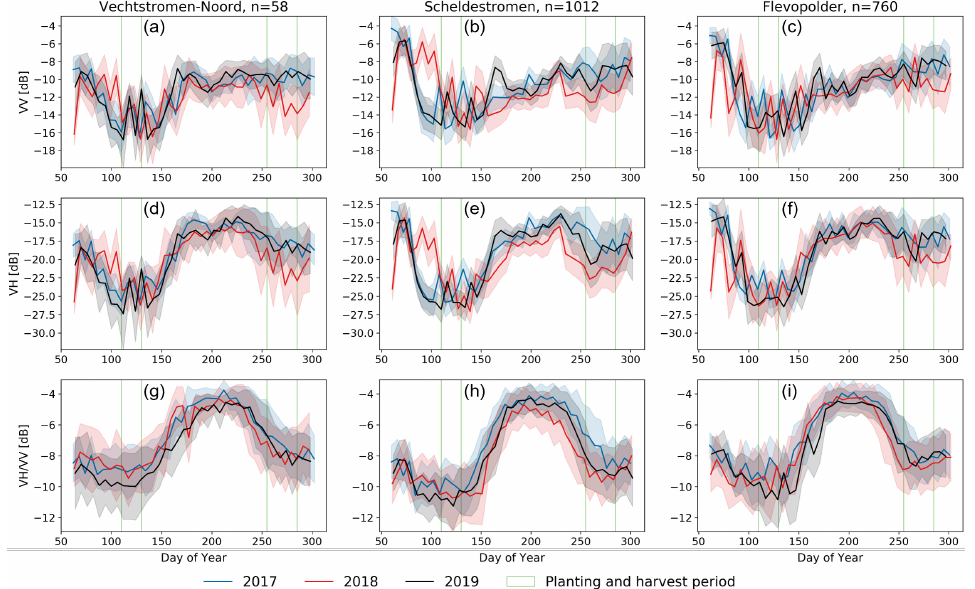
Figure 7. Averaged backscatter profiles of VV ( a – c ), VH ( d – f ) and VH/VV ( g – i ) for onion parcels in Vechtstromen-Noord (left), Scheldestromen (middle) and Flevopolder (right) for the years 2017, 2018 and 2019. The title of the columns states the number of maize parcels in each area. The shaded areas indicate the standard deviation calculated across all parcels. Vertical green lines indicate crop sowing and harvesting